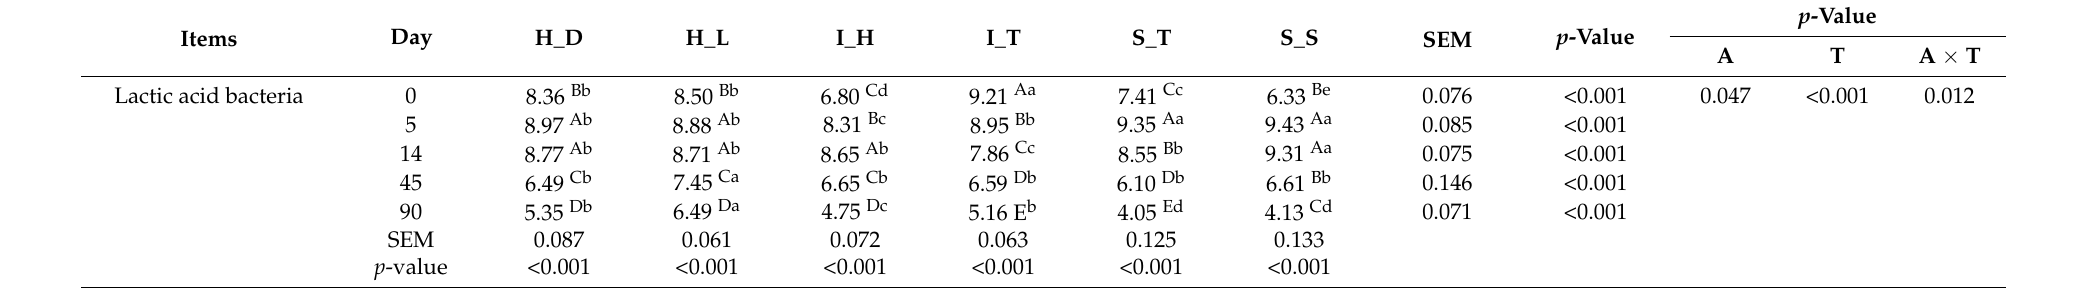
Table 2. Microbial counts (log colony-forming units/g fresh weight) of whole-plant corn silages during fermentation ( n =